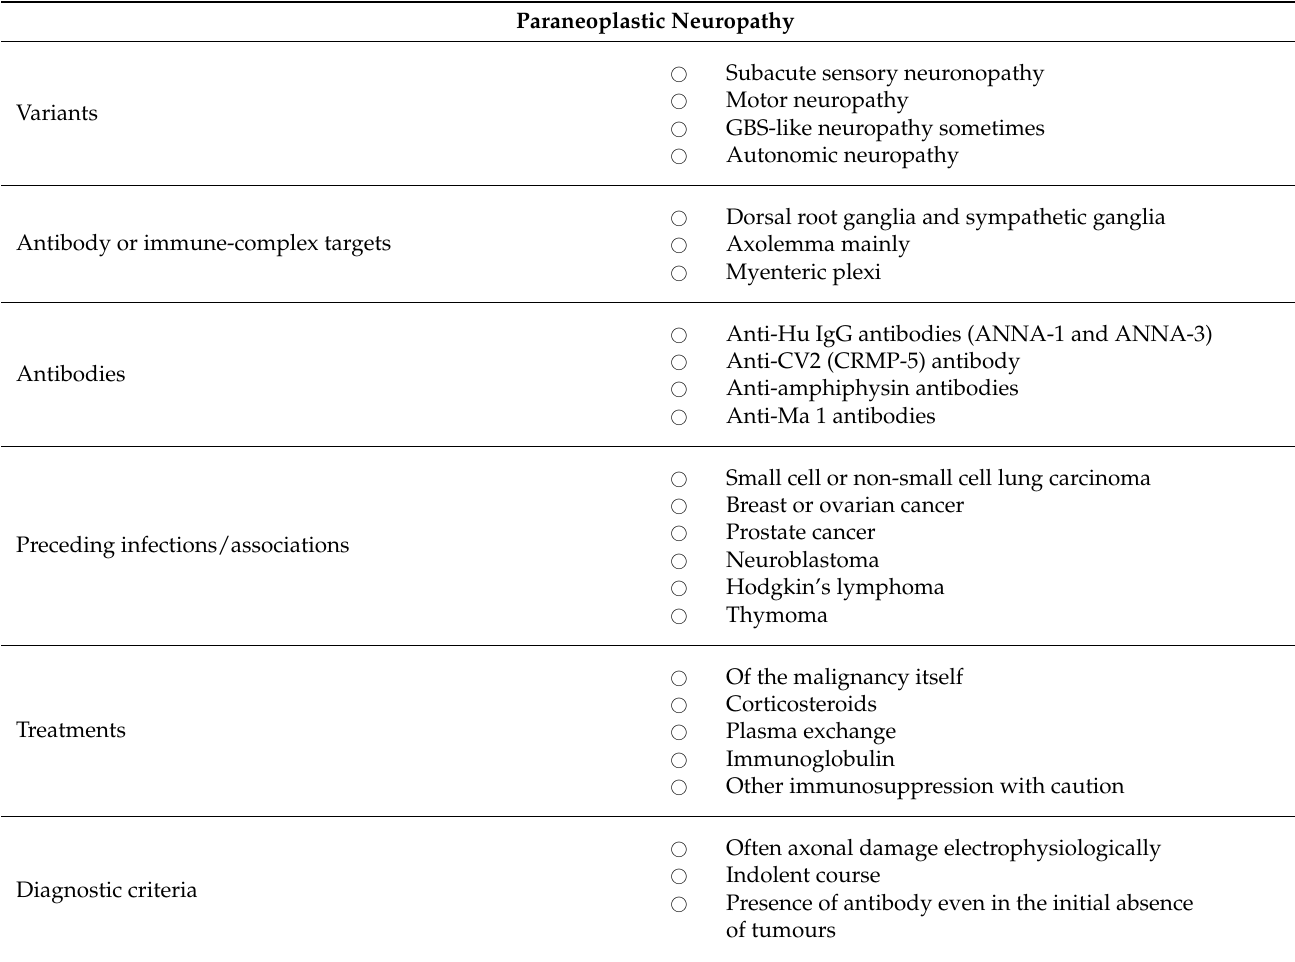
Table 2. Paraneoplastic neuropathies and their key